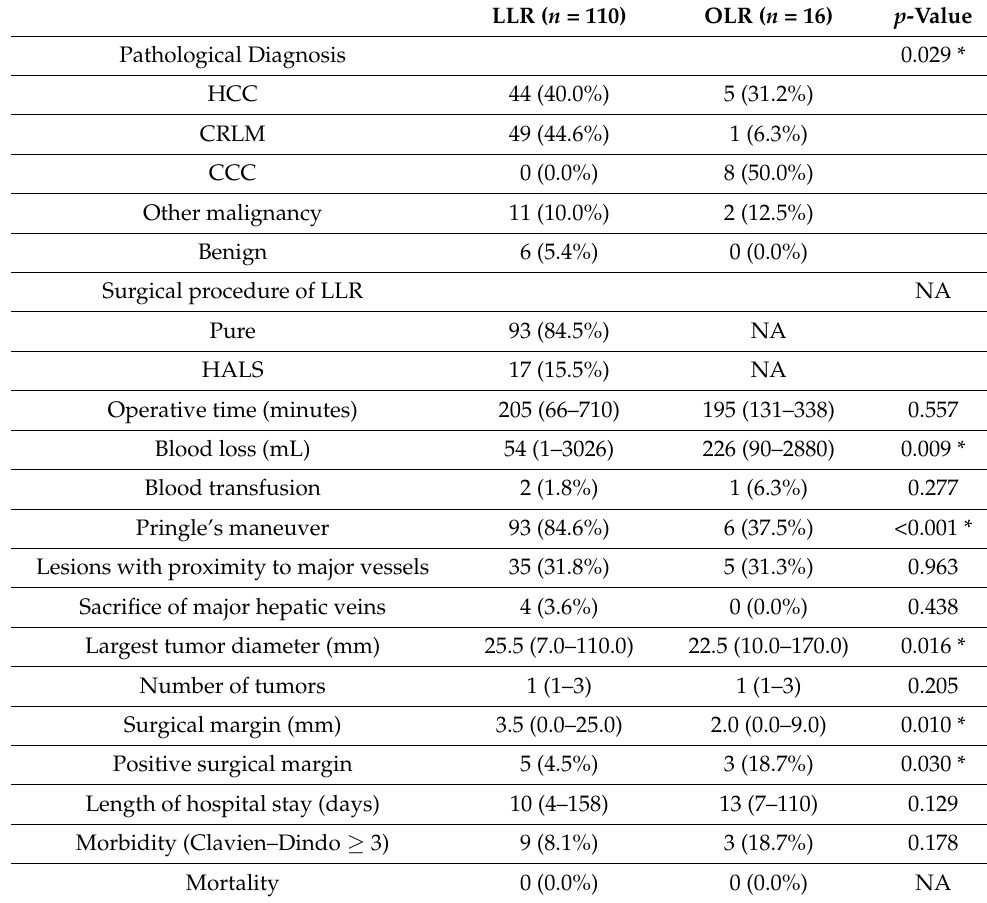
Table 2. Perioperative outcomes of LLR and OLR